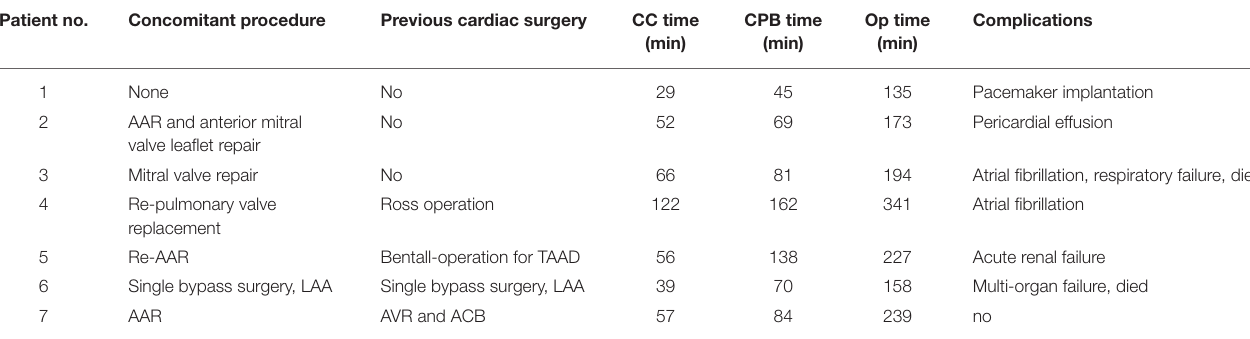
TABLE 2 | Surgical details. Patient no.